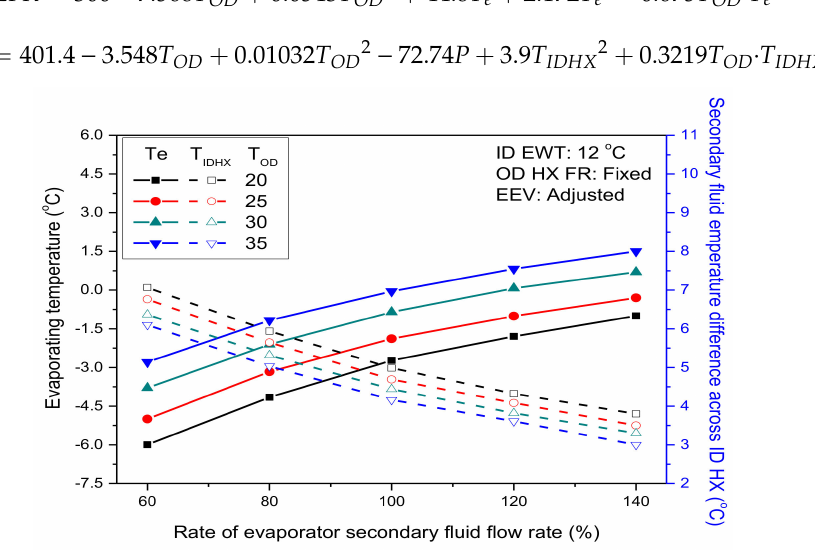
Figure 9. Relationship between evaporator SFFR and evaporating temperature.